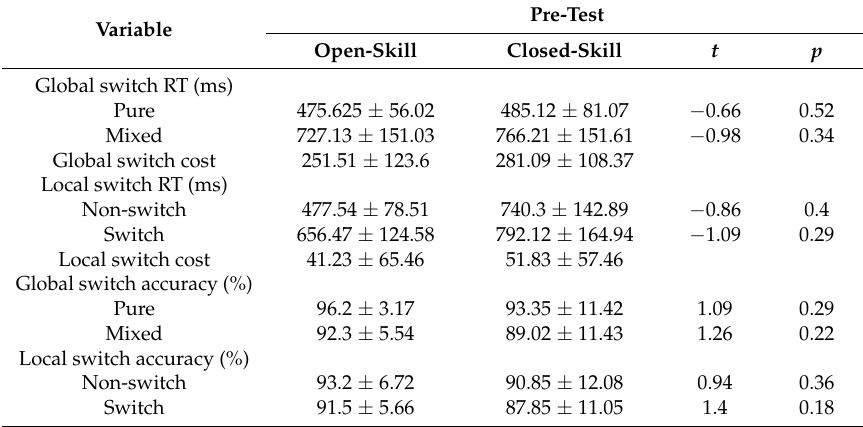
Table 2. Reaction time and accuracy for global switch and local switch among exercise session in pre-test (mean value ± standard